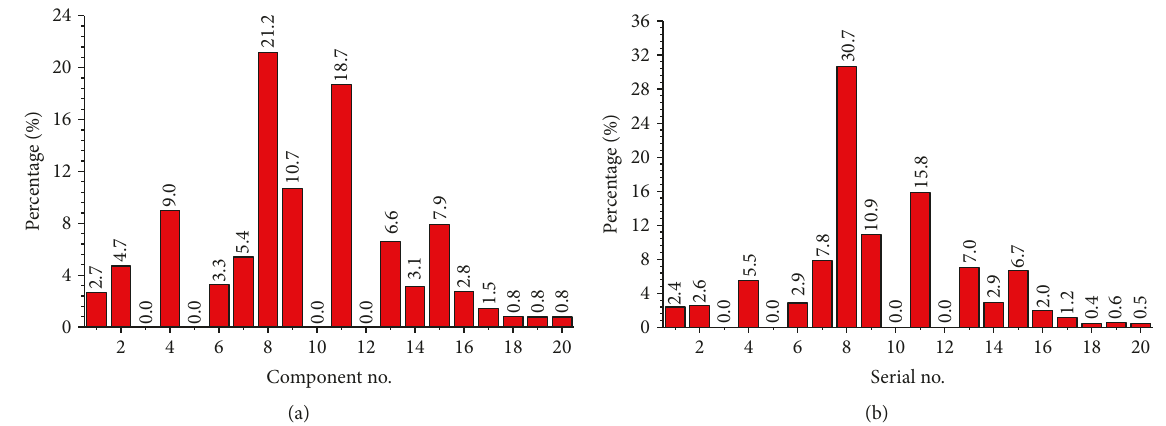
Figure 16: Contribution rate histogram (free fl ow speed: 83 m/s): (a) 400 Hz and (b) 800 Hz.